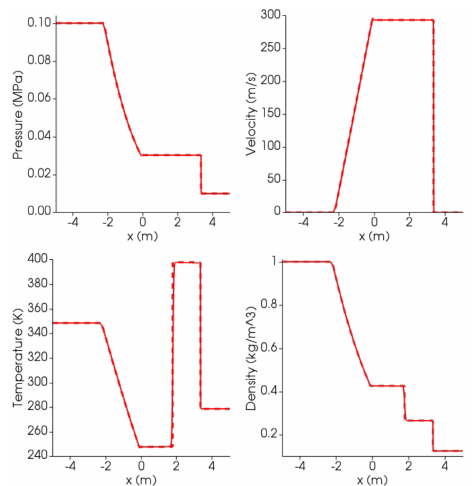
Figure C1. Results at time t = 0 . 006s for the air Sod shock tube. Dashed lines: analytical solution; solid lines: simulation. At time 0, the interface dividing the high-pressure (left, l) from low-pressure (right, r) zone is placed at 0m. Initial conditions: P l = 0 . 1MPa, P r = 0 . 01MPa; T l = 348 . 432 K , T r = 278 . 746 K ; gas volume frac- tion α l = 1, α r = 0; U l = U r = 0. Isobaric heat capacity is C P = 1004 . 5Jkg − 1 K − 1 , corresponding to heat capacity ratio γ = 1 .